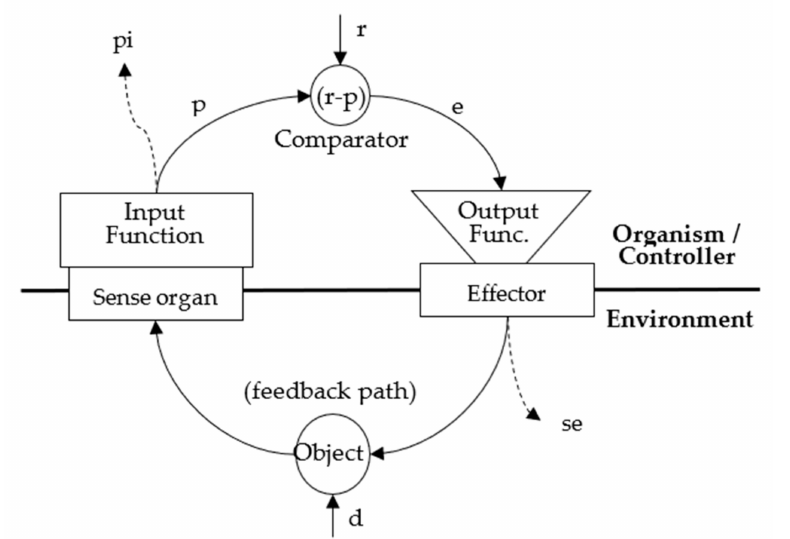
Figure 3. A simple basic level control loop has these parts and functions: An external Object in the environment affects the the Sense organ, which, together with the Input function transform the environmental effect to a perceptual signal ( p ). Then the Comparator (function) compares the perceptual signal p to the reference signal ( r ) and sends their difference (r − p) as an error signal ( e ) to the Output function, which, together with an Effector organ, converts the error signal into an environmental effect towards the external Object. The d arrow is a disturbance effect which throws the system off balance and thus causes the strengthening of the error. The effector’s operation tries to cancel the disturbance and return the system back to balance. The dashed arrow se means side-effects, and pi is a perceptual signal to somewhere else in an